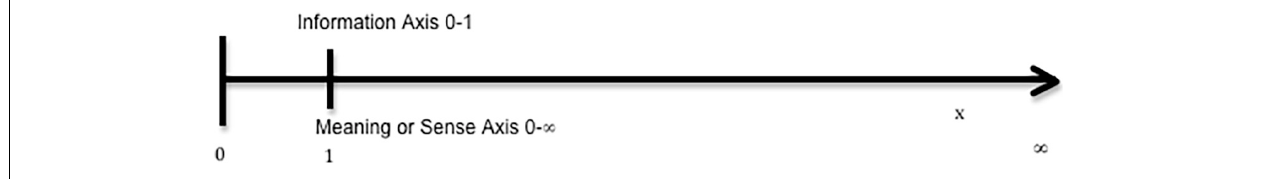
FIGURE 1 | Consciousness, meaning, and information. Consciousness in the Mental Maxwell model is a set of coordinate axes, each metering the amount of a different sensory quality, or attribute . An axis is shown for attribute x . The axis is oriented; it runs from a starting point (0) to a destination ( ∞ , or some finite maximum). This gives it sense or meaning . In going from origin to endpoint, one takes steps of a fixed size (1). Information is the number of these steps currently populating the axis, the value of the attribute. Note that information itself can be regarded as a minimalist axis (a bit-axis) where ∞ and 1 collapse leaving only 0 and 1. Thus, information alone has no sense and can enumerate any attribute. Alternatively, were consciousness maximized by breaking it up into bit axes (as one tends to do in meditation), it would ultimately degenerate into pure